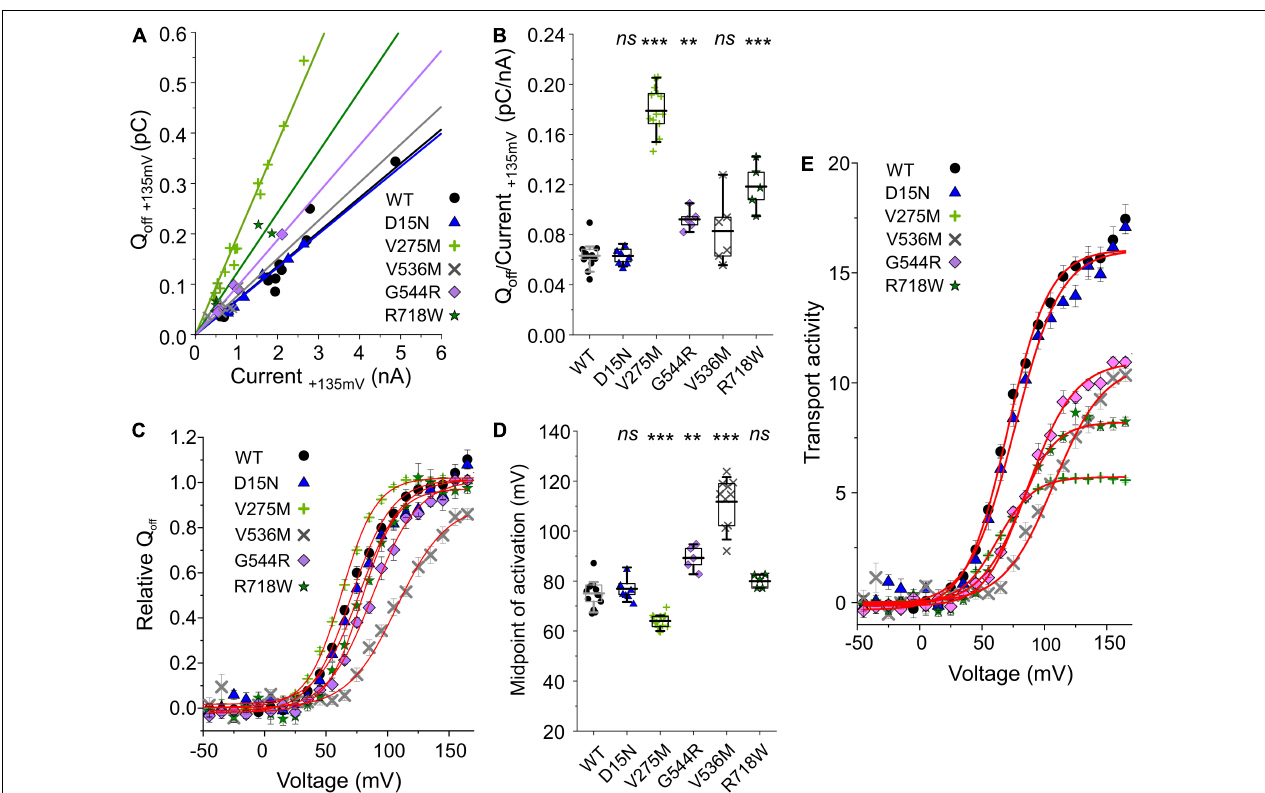
FIGURE 3 | Analysis of WT and mutant ClC-4 capacitive currents. (A) Plots of integrated capacitive current amplitudes at 0 mV ( Q off ) after a prepulse to +135 mV against the transport current amplitude at +135 mV for WT and mutant ClC-4 variants. (B) Q off /current ratios for WT and mutant ClC-4 variants (WT, n = 14; D15N, n = 7; V275M, n = 14; V536M, n = 6; and G544R, n = 5; R718W, n = 5). (C) ClC-4 activation curves constructed by plotting the mean value ± s.e.m. of the normalized Q off against the preceding voltage. Solid lines provide fits to single Boltzmann functions. (D) Mean values for the midpoint of activation ( V 0 . 5 ) obtained from Boltzmann fits to the Q off - V relationship for WT and mutant ClC-4 variants (WT, n = 14; D15N, n = 7; V275M, n = 14; V536M, n = 10; G544R, n = 5; and R718W, n = 5). *** p < 0.001, **p < 0.01, and ns (not significant). (E) Comparison of the transport activities of WT and mutant ClC-4. Transport activities were calculated by dividing normalized Q off determined after various prepulses by Q off /current ratios shown in (B) . ClC-4 mutants were compared with WT using